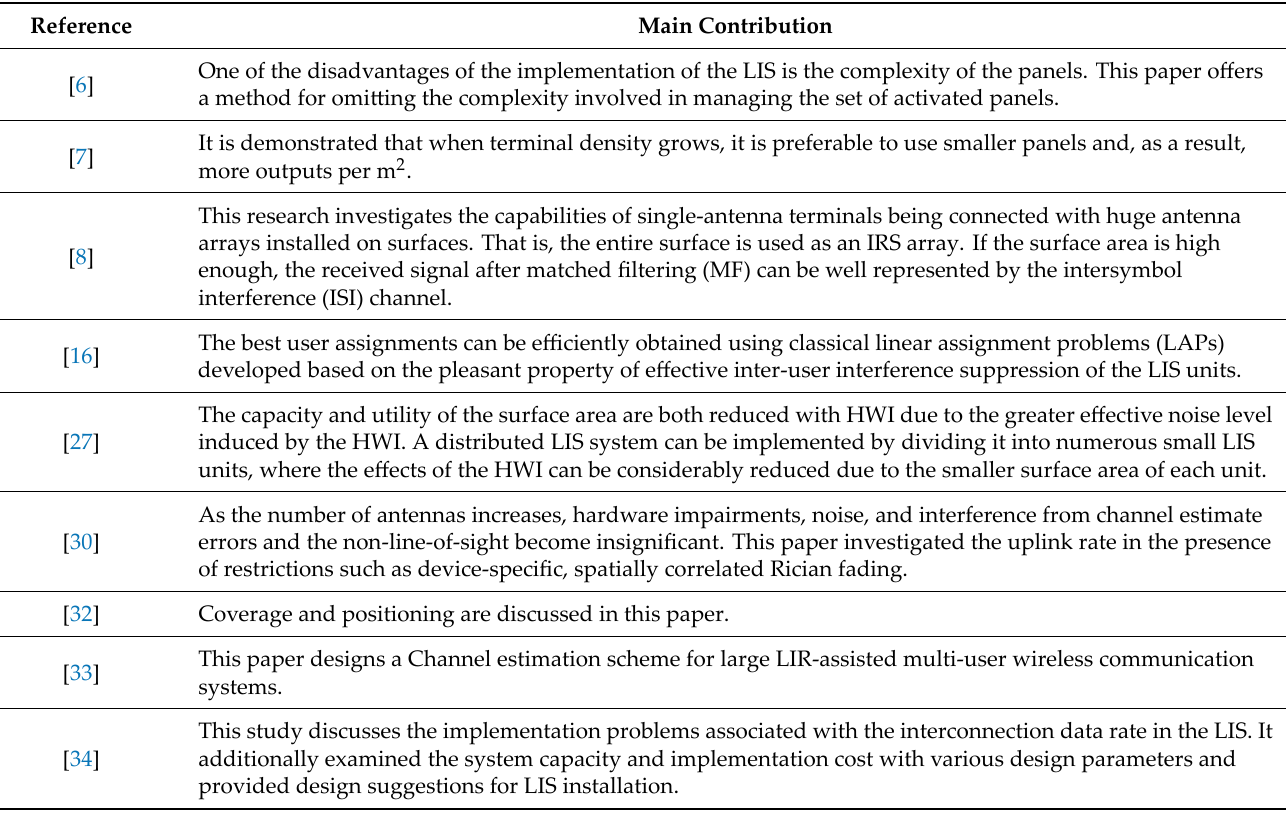
Table 2. Representative Overview of Recent Research on the